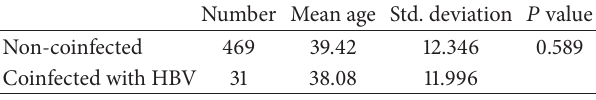
Table 1: Coinfection rate of HBV and HCV.